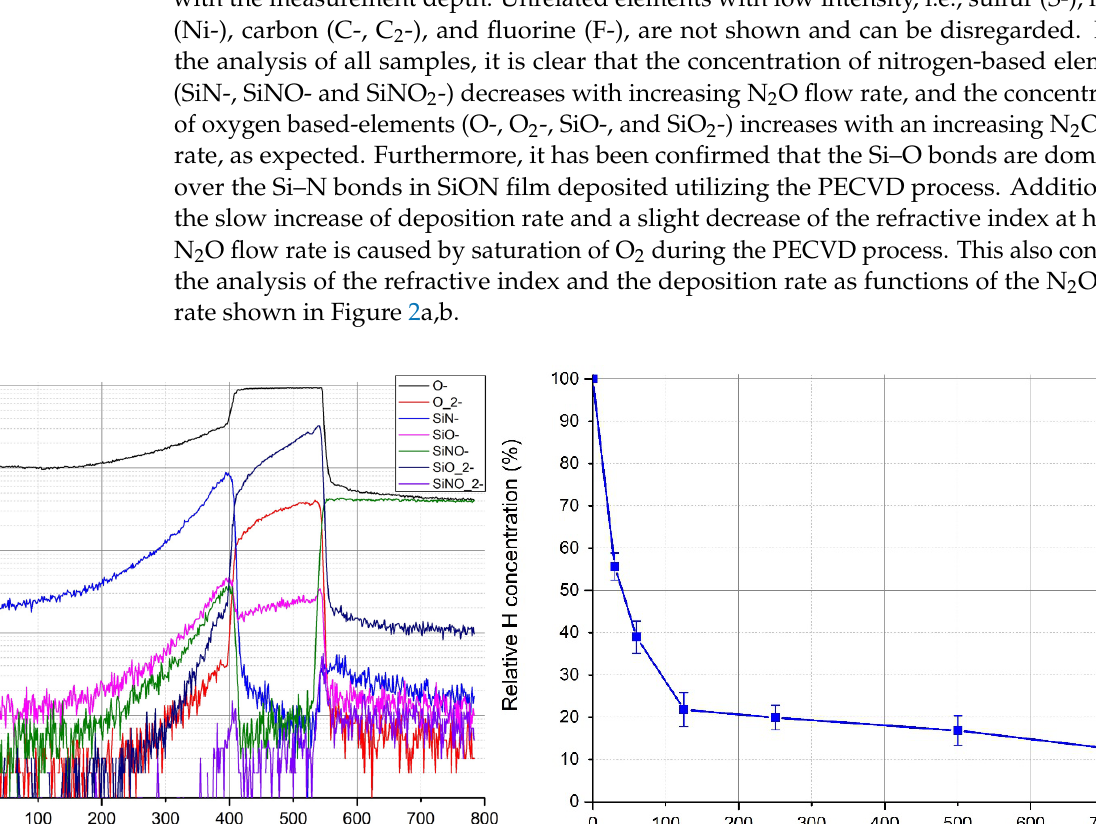
Figure 3. Refractive index as a function of wavelength for SiN, SiO x , and SiON films acquired us-